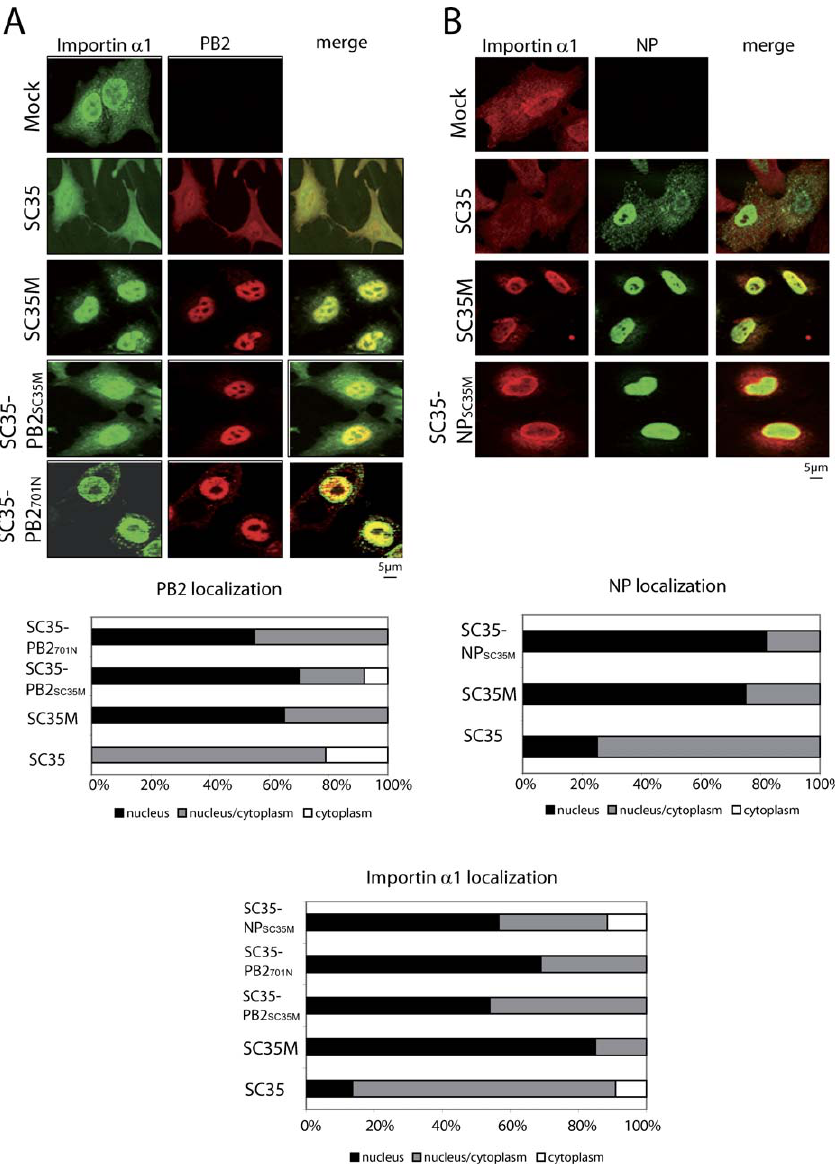
Figure 6. Localization of PB2, NP, and Importin a 1 in Mammalian Cells by Immunofluorescence